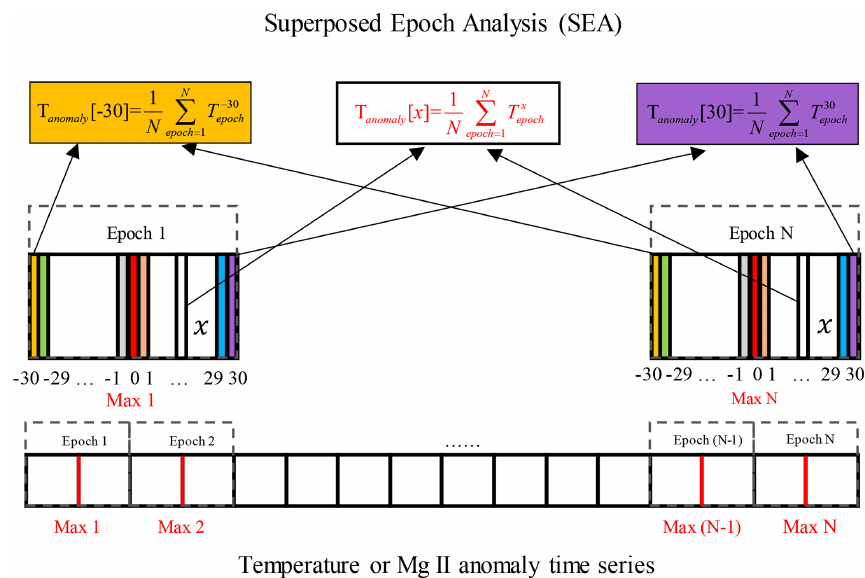
Figure 5. Overview of the superposed epoch analysis (SEA). It should be noted that the epochs are allowed to overlap even though we do not show it in the figure.